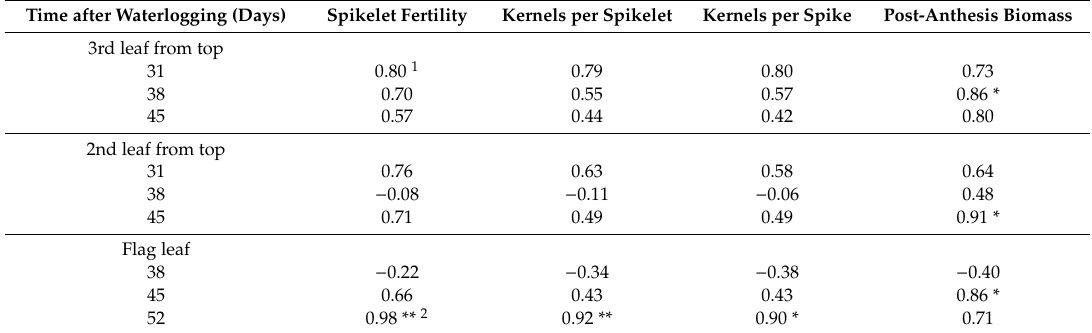
Figure 2. Variations in green leaf area of ( A ) the 3rd leaf from the top, ( B ) the 2nd leaf from the top, and ( C ) flag leaf relative to the water drainage treatment (DR) for different remedial treatments after waterlogging. ns, *, and ** indicate the non-significant difference and the significant difference at p < 0.05 and p < 0.01, respectively, in the green leaf area among the water drainage treatment (DR), the waterlogging treatment (WA), and the remedial treatments (FU1, FU2, SU1, and SU2). Table 3. Correlation coe ffi cients of spikelet fertility, kernels per spikelet, kernels per spike, and post- anthesis biomass with green leaf area of the top three